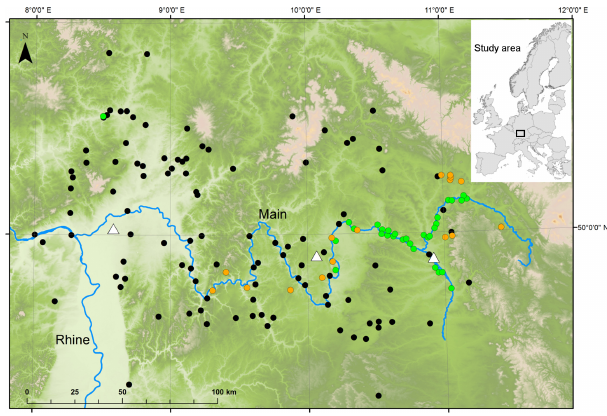
Figure 1. Study area. Locations of the tree-ring sites and meteo- rological stations in the Main region. The study area is located be- tween 49.3–50.8 ◦ N and 8.2–12.2 ◦ E. Sites of living trees (orange dots), localities of historical samples from construction wood (black dots) and gravel pits of alluvial deposit subfossil oaks (green dots) are shown. The three meteorological stations (white triangles) are located in the eastern, middle and western parts of the study